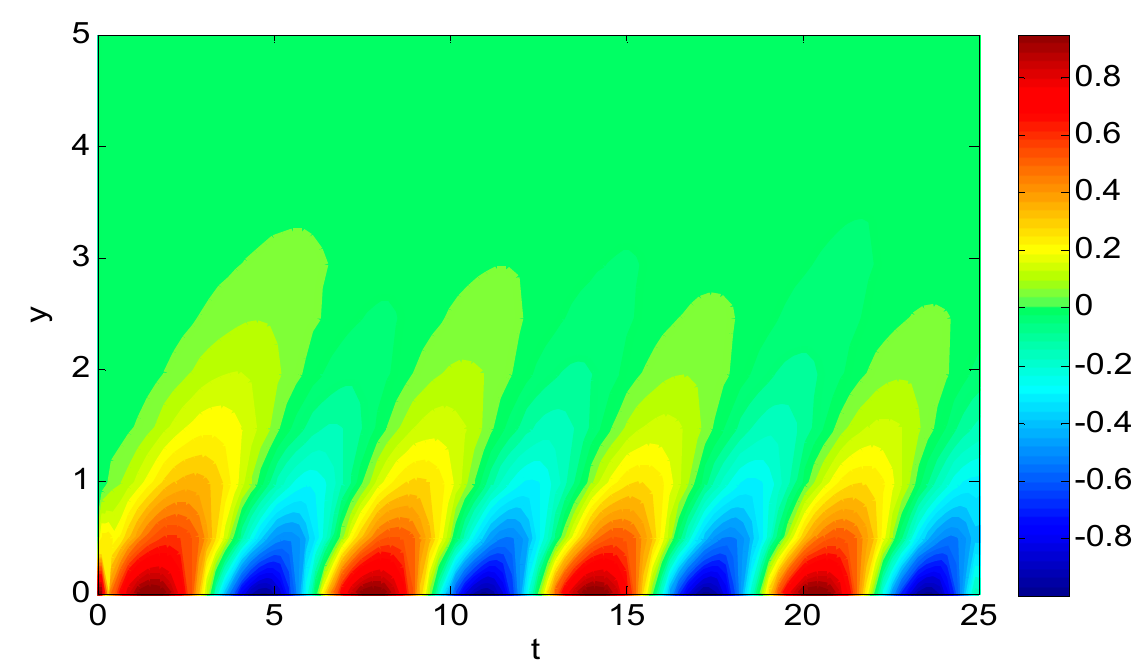
Figure 14. Contour plot for temperature profile of Stokes’ second problem in Quantum Calculus by the proposed scheme for spatial direction and Crank–Nicolson scheme for time direction using N y = 50, N t = 100, λ = 0.01, β = 0.01, Pr = 3, q = 0.8, L = 24, u ( t ,0 ) = cos ( t ) , θ ( t ,0 ) = sin ( t )